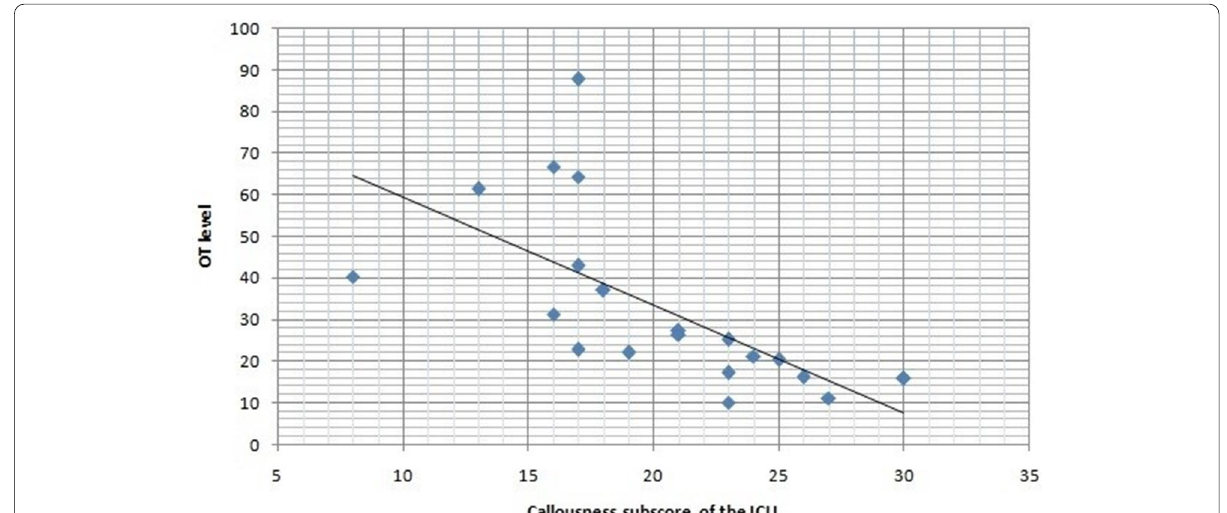
Fig. 3 Correlation between oxytocin levels and the callousness subscore of the Inventory of Callous-Unemotional Traits (ICU—self - report)